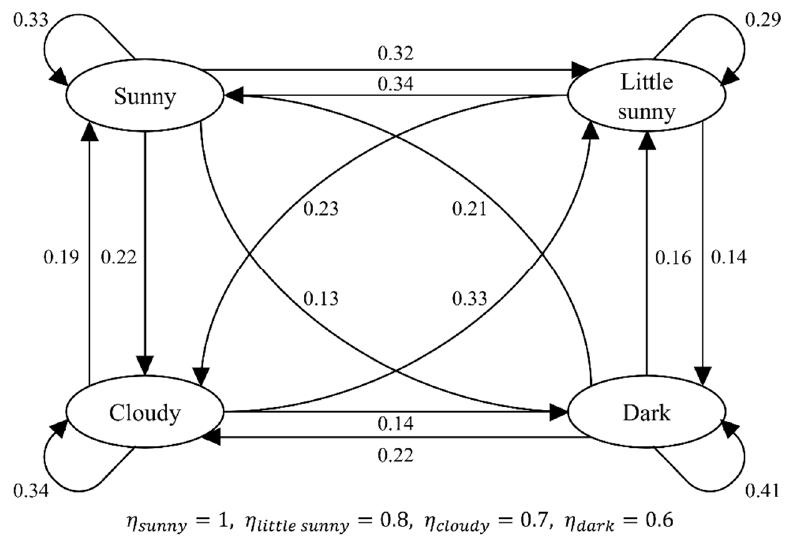
Figure 2. Transition probability and energy production efficiency of weather.